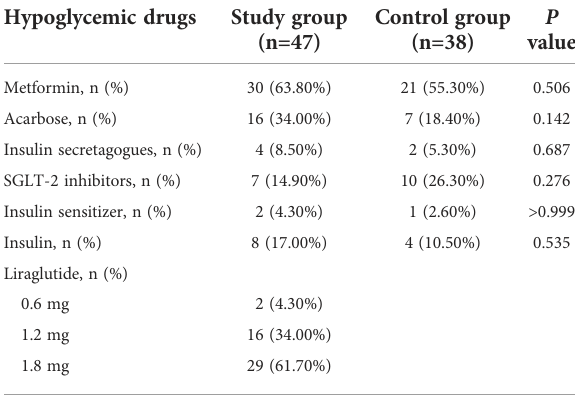
TABLE 1 Comparisons of hypoglycemic drugs used in two groups of